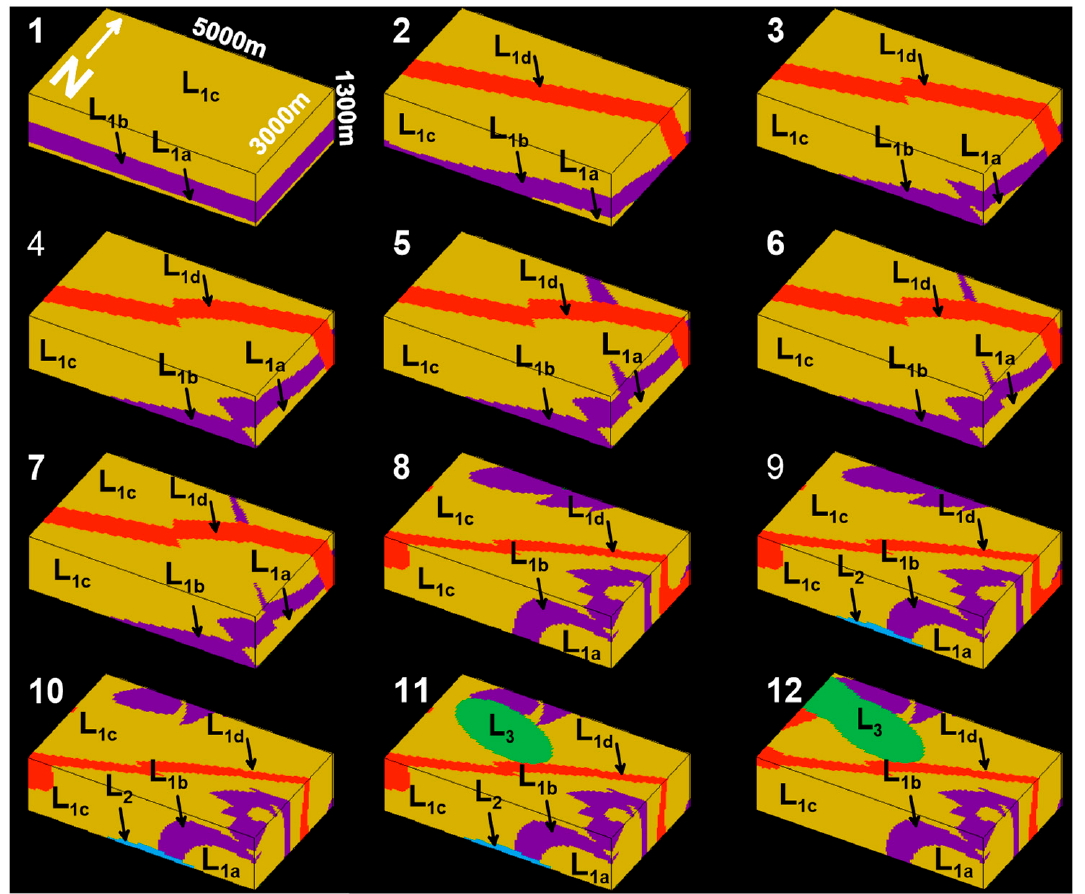
Figure 3. Construction of geological features. Reference geological model was selected at the end of stage 12 with three major geological features: a background geology ( L 1a , L 1b , L 1c , L 1d ) and two separate alteration overprints overlapped over the background geological features ( L 2 , L 3 ).